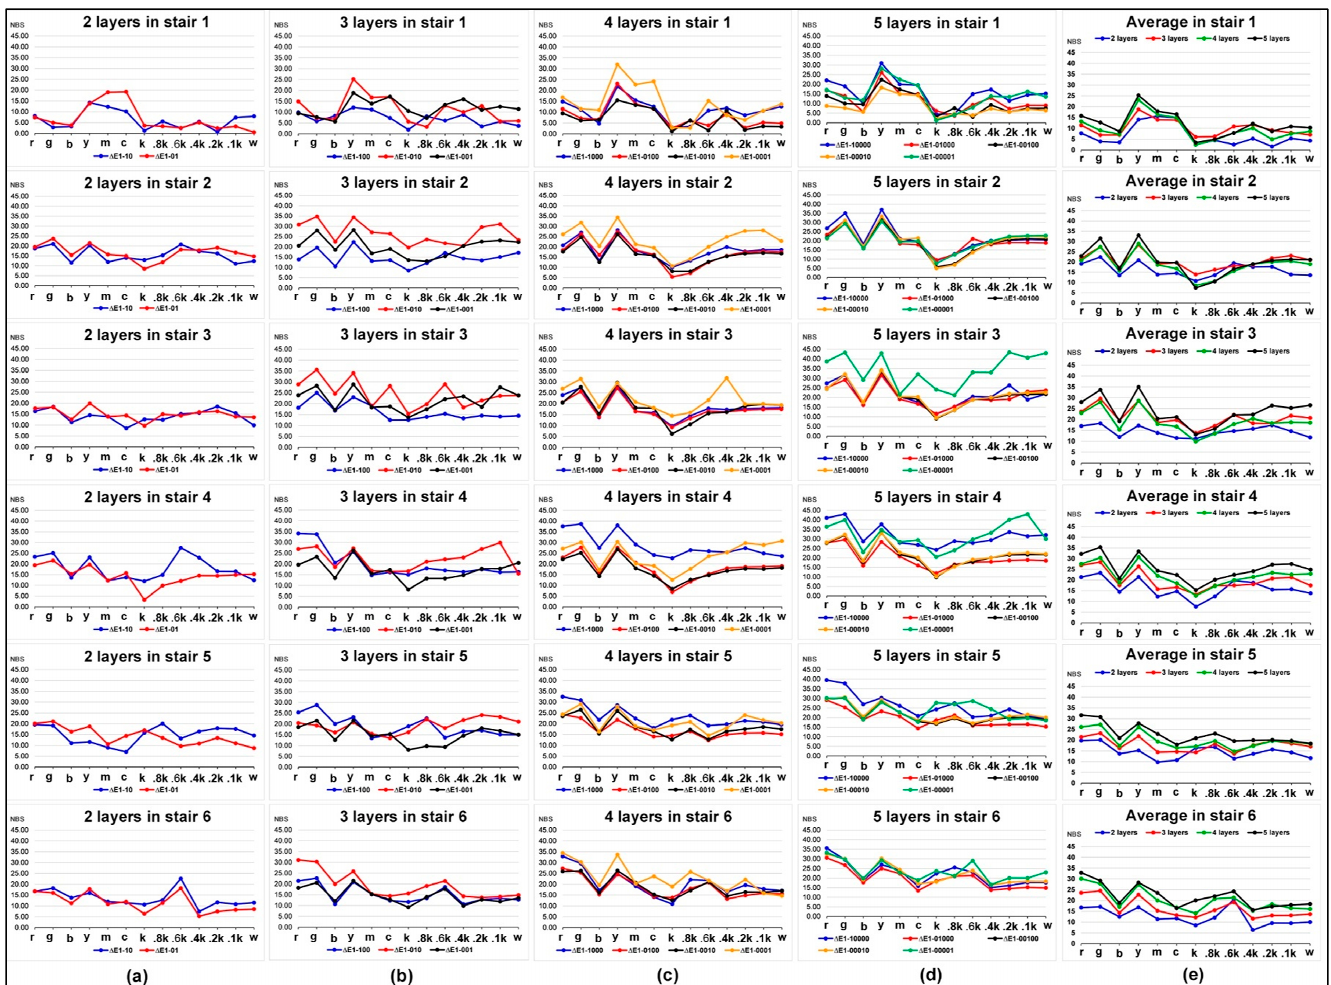
Figure 2. Chromatic aberration between samples with multiple printed layers and samples with one single layer (sample ID 1): ( a ) 2 layers; ( b ) 3 layers; ( c ) 4 layers; ( d ) 5 layers; ( e )